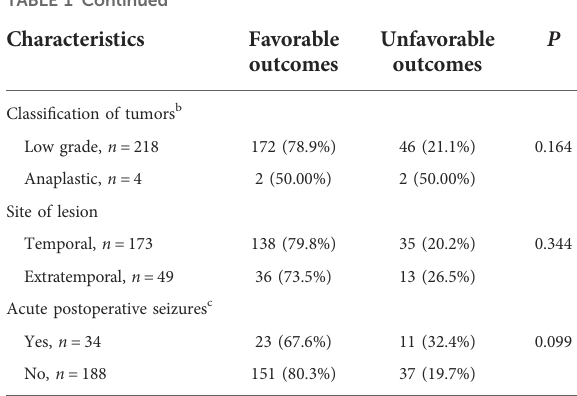
TABLE 1 Demographic and clinic characteristics of patients and the relationship with seizure